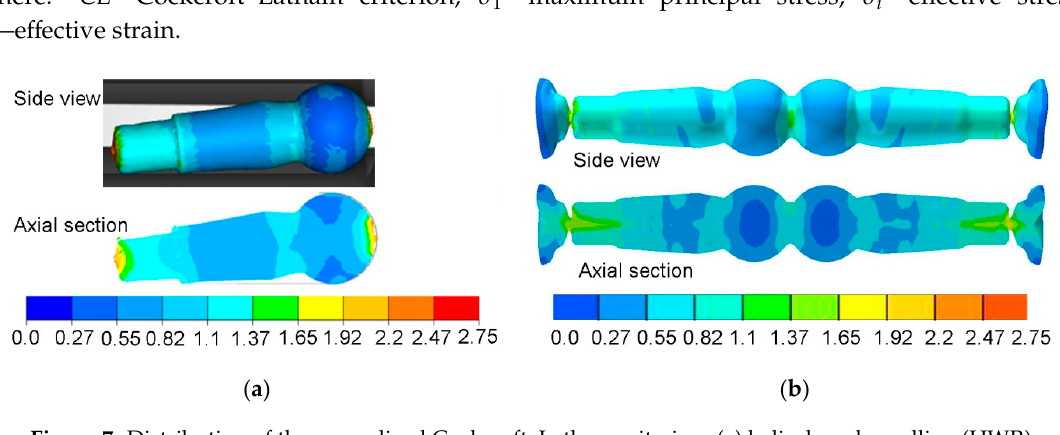
Figure 7. Distribution of the normalized Cockcroft–Latham criterion: ( a ) helical-wedge rolling (HWR) stud; ( b ) cross-wedge rolling (CWR) stud.